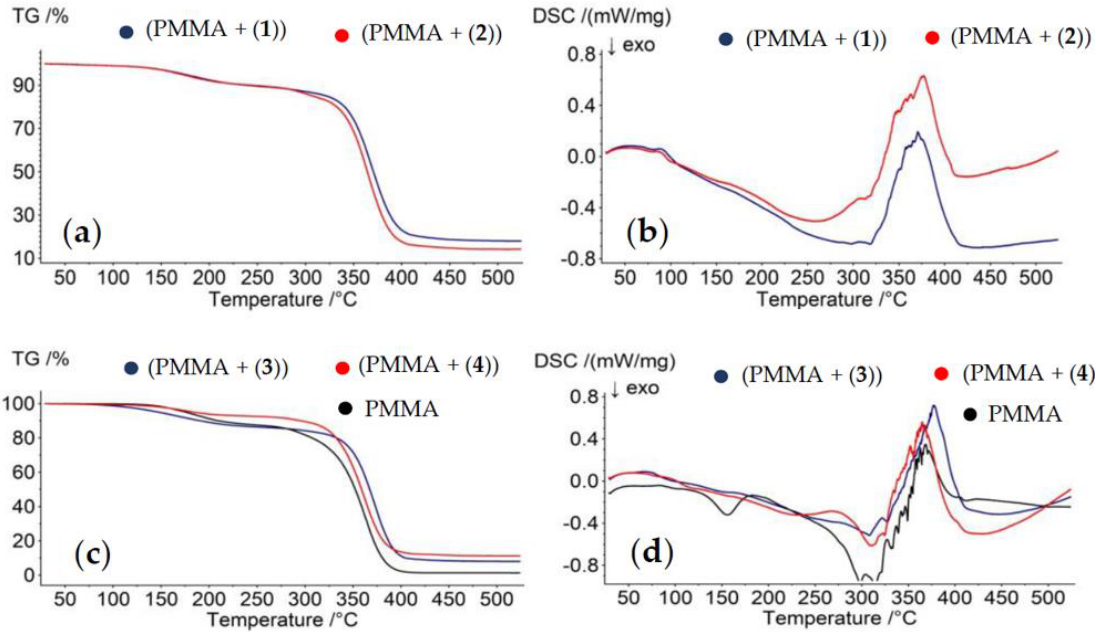
Figure 6. Thermogravimetric curves (TGA) ( a , c ) and the differential scanning calorimetry curves of (DSC) ( b , d ) of the produced composite materials (PMMA + ( 1 ) – ( 4 )) and PMMA. (DSC) ( b , d ) of the produced composite materials (PMMA + ( 1 )–( 4 )) and